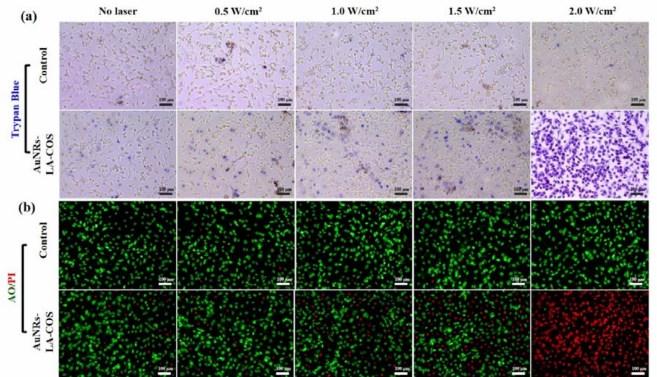
Figure 5. ( a ) Optical images stained by trypan blue and the optical image of MDA-MB-231 cells incubated with or without AuNRs-LA-COS (25 µ g/mL) under 808 nm NIR laser irradiation at different power densities (0.5, 1.0, 1.5, and 2.0 W/cm 2 ) for 5 min (20 × magnification). ( b ) Merged fluorescence images of MDA-MB-231 cells treated with or without AuNRs-LA-COS (25 µ g/mL), with or without 808 nm NIR laser irradiation at different power densities (0.5, 1.0, 1.5, and 2.0 W/cm 2 ) for 5 min (20 ×